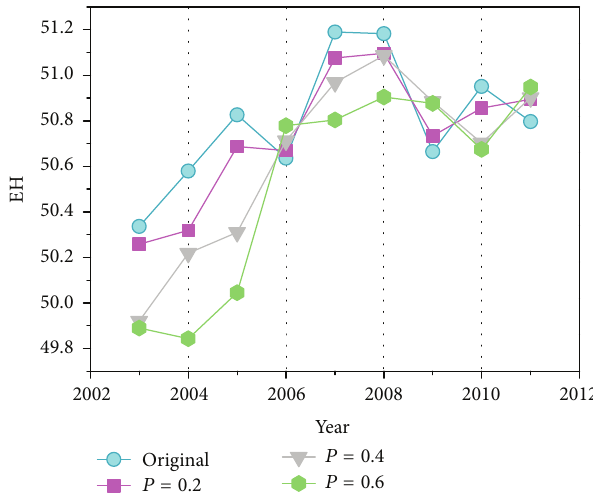
Figure 6: Comparisons with the original network for various fractions of links are removed from the network for 𝑃 = 0.2 , 0.4, 0.6, respectively.